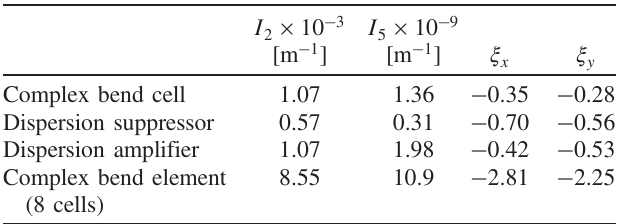
TABLE III. Synchrotron integrals and chromaticity corre- sponding to the complex bend, dispersion suppressor and dispersion